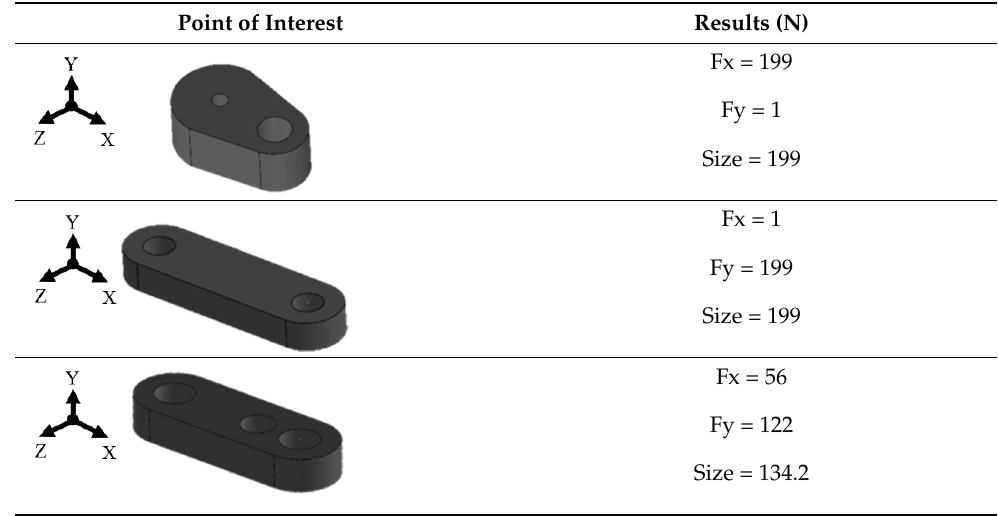
Table 4. Reaction forces of the six-bar mechanism.